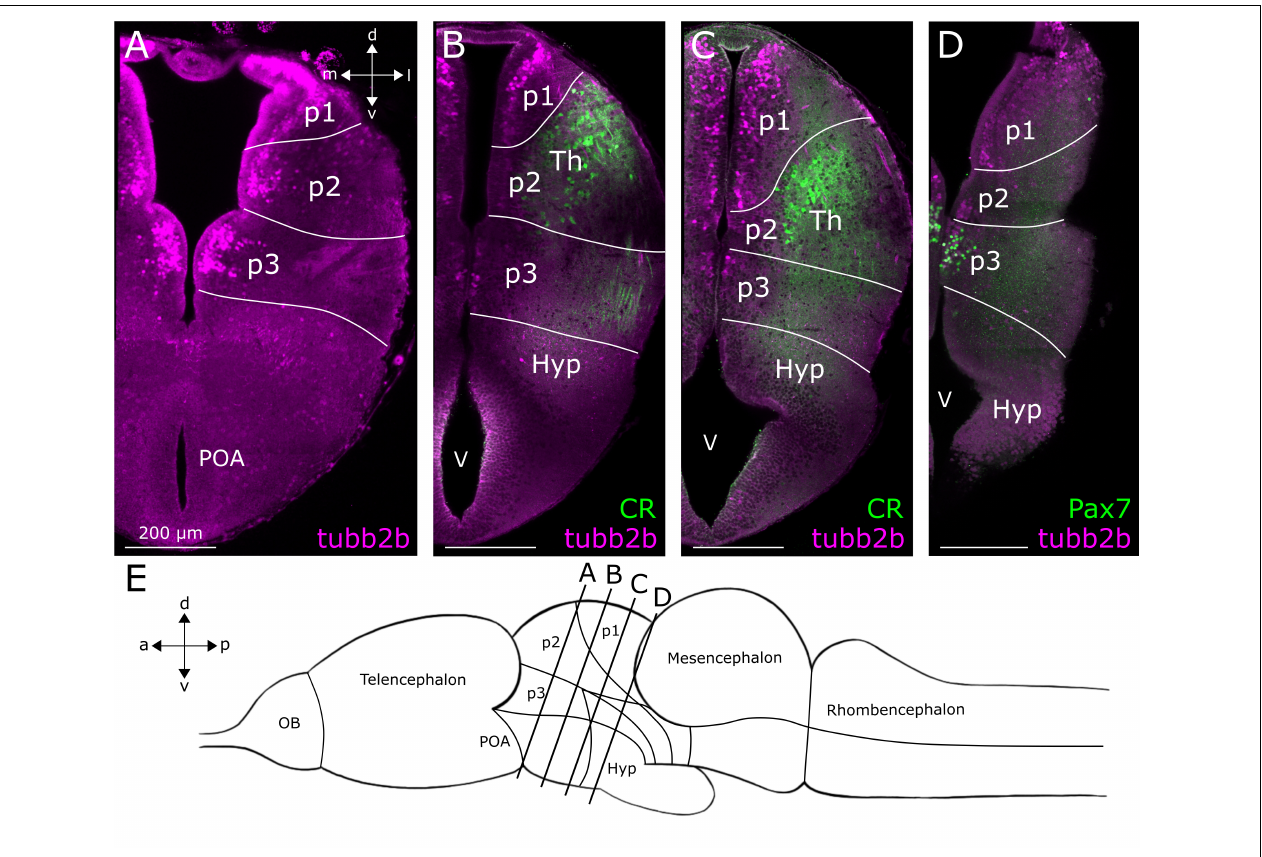
FIGURE 5 | Location of tubb2b -dependent fluorescence in the diencephalon of larval Xenopus laevis . Coronal sections through the diencephalon of NBT-Katushka γ -cry-Venus transgenic tadpoles. (A) tubb2b -dependent fluorescence (magenta) in cells of prosomeres 1–3 (p1–3). (B) No tubb2b -dependent fluorescence could be detected in calretinin-positive cell bodies and fibers (CR; green) of the thalamus (Th). (C) tubb2b -dependent fluorescence-positive cell bodies in the area of the Th. CR-positive cells and fibers were not tubb2b -positive. (D) Cells in prosomere 3 (p3) did not show tubb2b -dependent fluorescence but could be stained with an antibody against Pax7 (green). (E) Approximate positions of the sliced regions are shown in a schematic image of the larval brain (lines). OB, olfactory bulb; Hyp, hypothalamus; POA, preoptic area; V, ventricle; d, dorsal; v, ventral; a, anterior; p, posterior; m, medial; l,